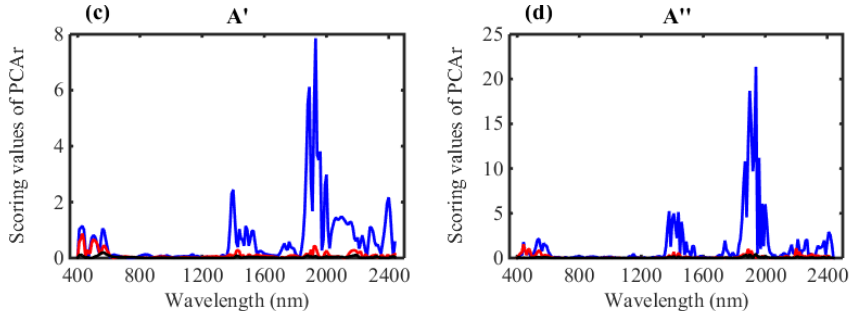
Figure 3. First three scoring values of hyperspectral reflectance variables: ( a ) Reflectance (R); ( b ) Normalized Reflectance (N); ( c ) First Derivative of log(1/R) (A ′ ) and ( d ) Second Derivative of log(1/R) (A ″ ) for SL + C + SC samples.